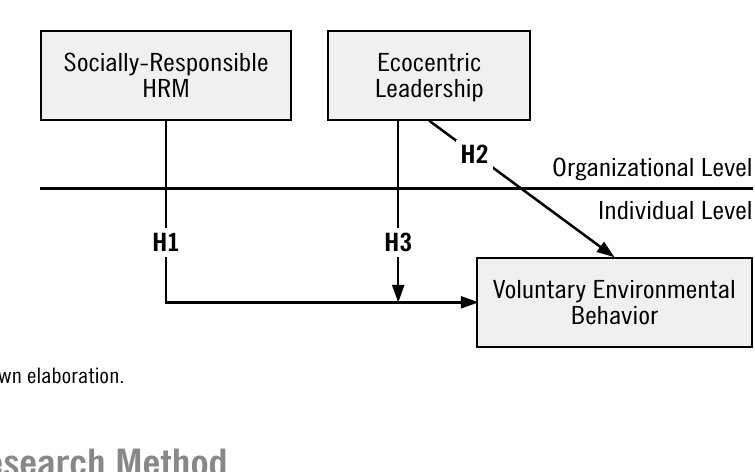
Figure 1. Conceptual research framework